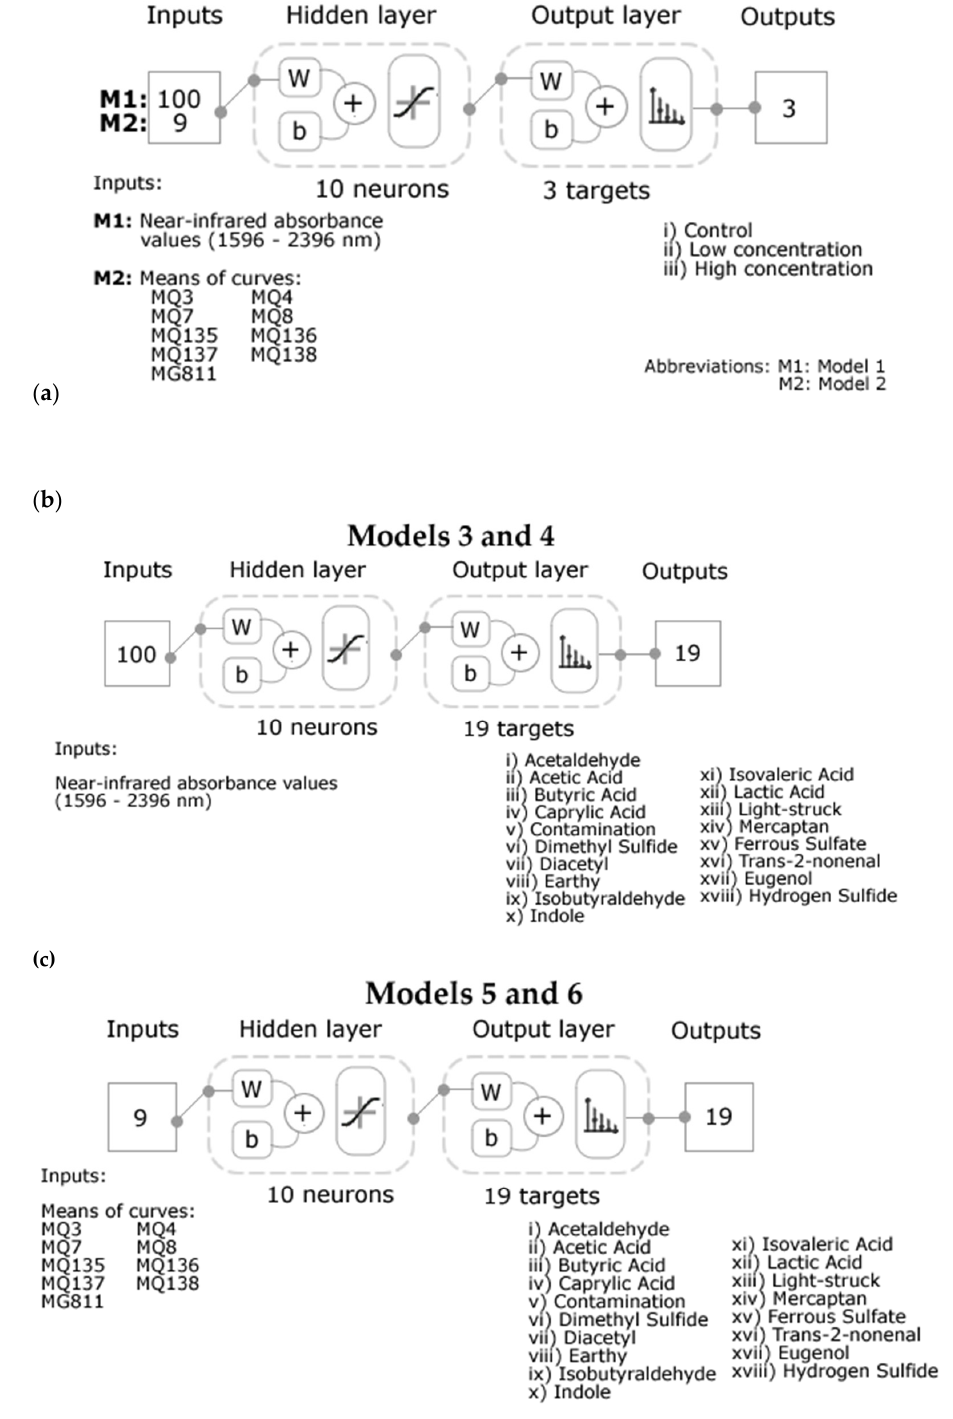
Figure 1. Diagrams of the two-layer feedforward models with a tan-sigmoid function in the hidden layer and a Softmax function in the output layer for ( a ) Models 1 (Near-infrared inputs), and 2 (electronic nose inputs), ( b ) Models 3 (low concentration) and 4 (high concentration), and ( c ) Models 5 (low concentration) and 6 (high concentration). Abbreviations: W: weights; b: bias.